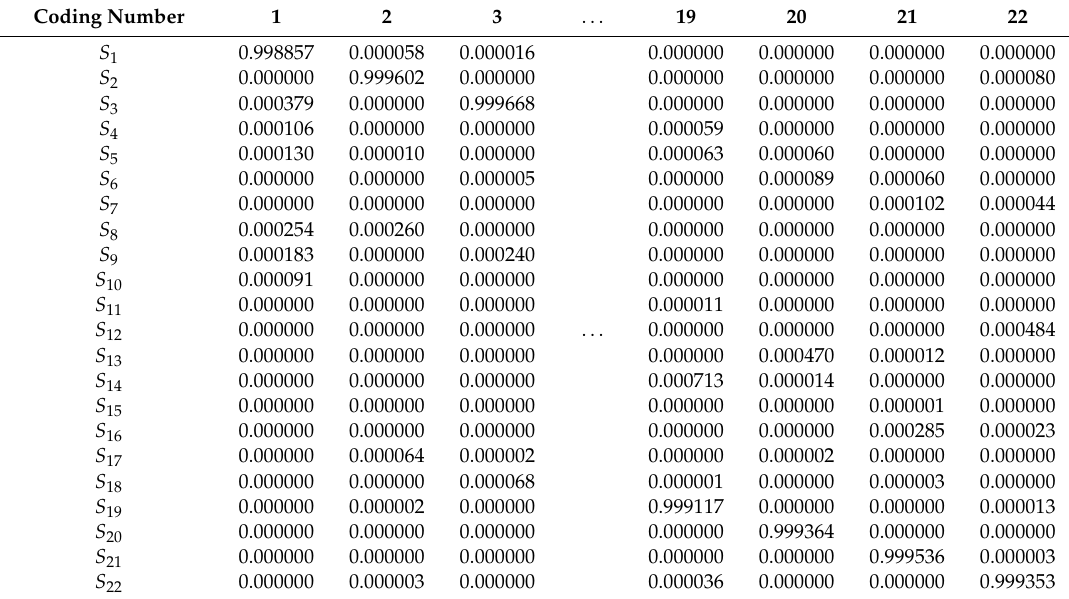
Table 8. The probability output results of Softmax and corresponding failure coding